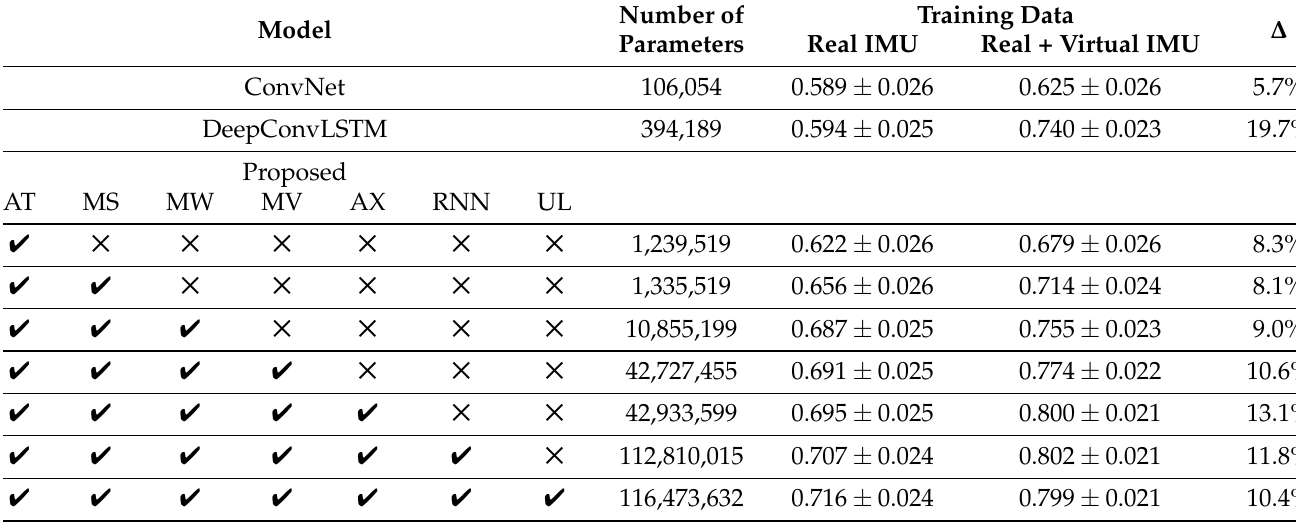
Table 2. Classification performance (mean F1 score, Wilson score interval) for our experimental evaluation. The baseline models are a standard four-layer convolutional models (ConvNet) and the DeepConvLSTM architecture [7]. Starting from ConvNet, we incrementally added individual components of the proposed model architecture to evaluate the effect of each of them along with the assessment of the overall effect more complex HAR model architectures have on recognition performance. The components are listed as follows: Adaptive trimming (AT, Section 3.2), multi-scale feature extraction (MS, Section 3.3.1), multi-kernel window feature extraction (MW, Section 3.3.2), multi-view convolution for temporal-channel feature extraction (MV, Section 3.3.3), skip connections from intermediate layer features (AX, Section 3.4.2), 2-layer MS-GRU unit for temporal aggregation of convolutional features (RNN, Section 3.4.3), and sample uncertainty modeling (UL, Section 3.5). The number of model parameters is shown to provide a direct comparison of the model complexity. The last column shows the performance difference, ∆ in percentage, when using virtual IMU data for model training.